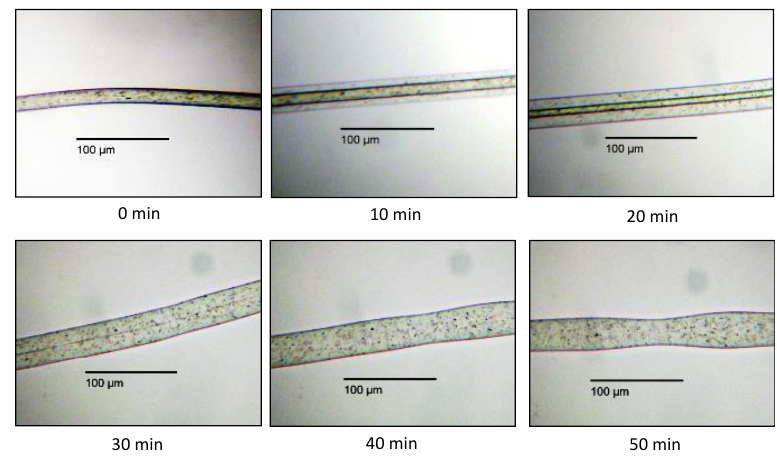
Figure 4. Swelling of PA 6.6 fibre in swelling solvent (SW).